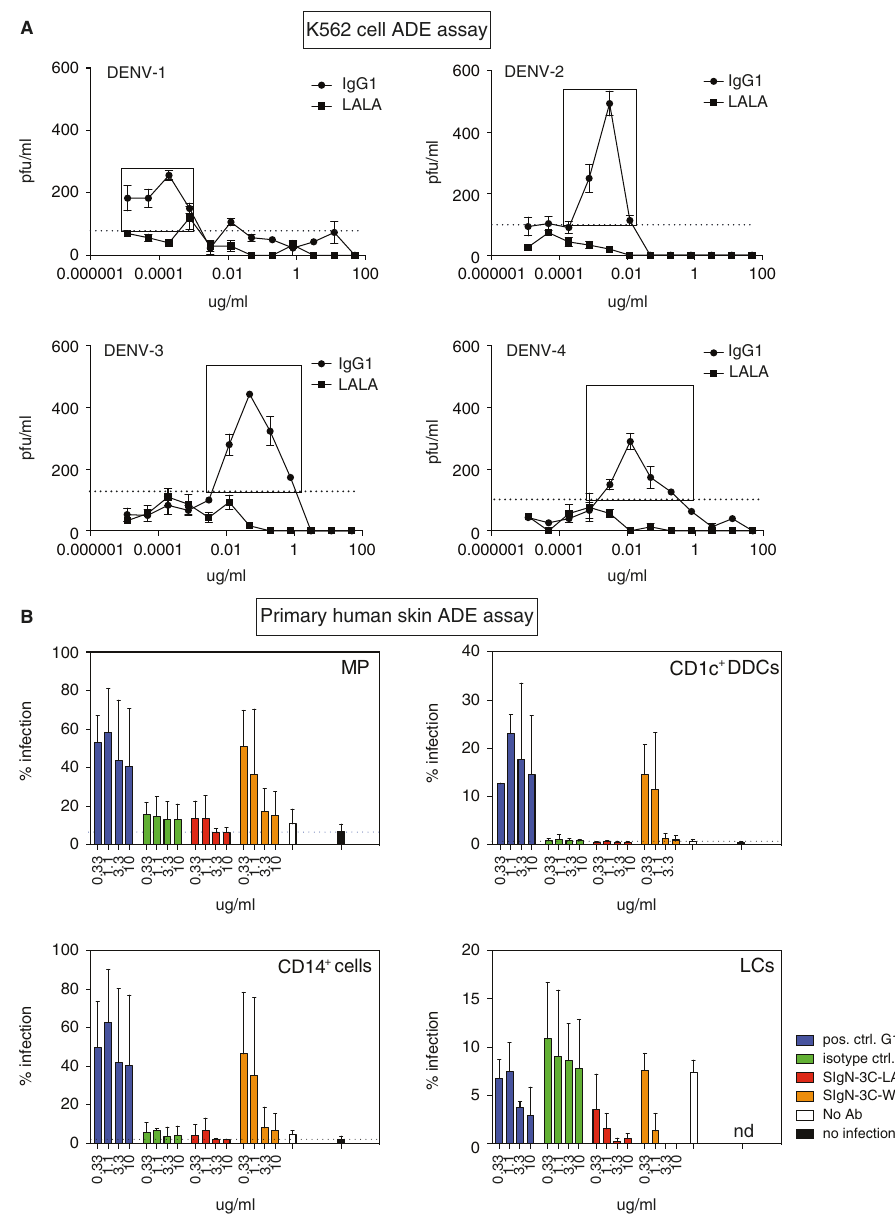
Fig. 3 SIgN-3C-LALA shows no enhanced infection in human cells. a Antibody-dependent enhancement on K562 cells for SIgN-3C IgG1 ( circles ) and SIgN-3C-LALA ( squares ). Means ± SD are shown. The dotted line indicates the limit of detection. Virus in the supernatant of infected K562 cells was quanti fi ed in a plaque assay. Enhancement observed with the IgG1 variant ( boxes ) was abrogated with the LALA variant. b ADE and neutralization in ex vivo human skin single cell suspensions. CD1c + DDCs: CD1c + dermal dendritic cells; CD14 + cells: macrophage precursor/dendritic cells, MP: macrophages, LC: Langerhans cells. Bars represent means ± SD of individual values pooled from three independent experiments using skin from different donors (with the exception of G10 and HA, for which the two highest Ab concentrations were only tested in two experiments). The dashed lines indicate the background observed in non-infected cells. Different y -axis scales for individual cell types were used due to different levels of infection. nd: not